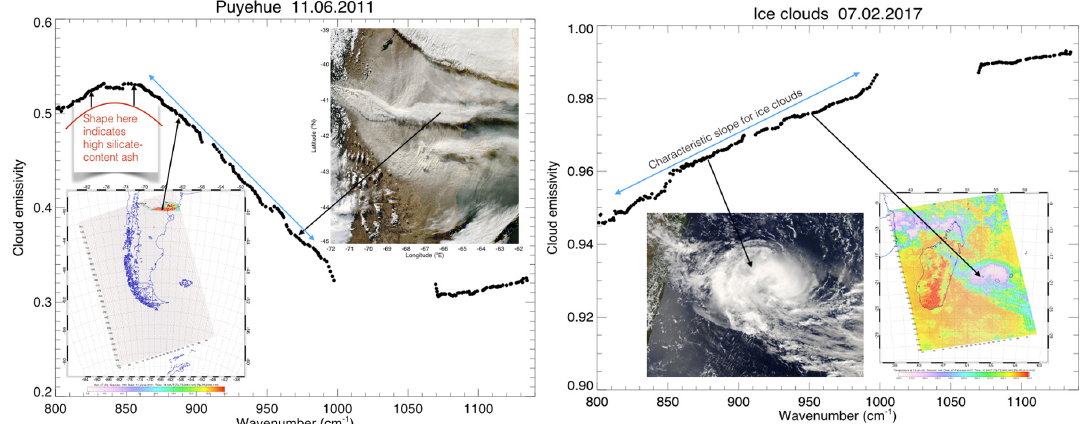
Figure 17. Satellite measurements illustrating the spectral discrimination capability of the Airborne Spectroscopic Hazards (ASH) imager. Left: Satellite measurements for an ash cloud–cloud emissivity vs. wavenumber. Right: Satellite measurements for high altitude cirrus cloud generated by a tropical cyclone.